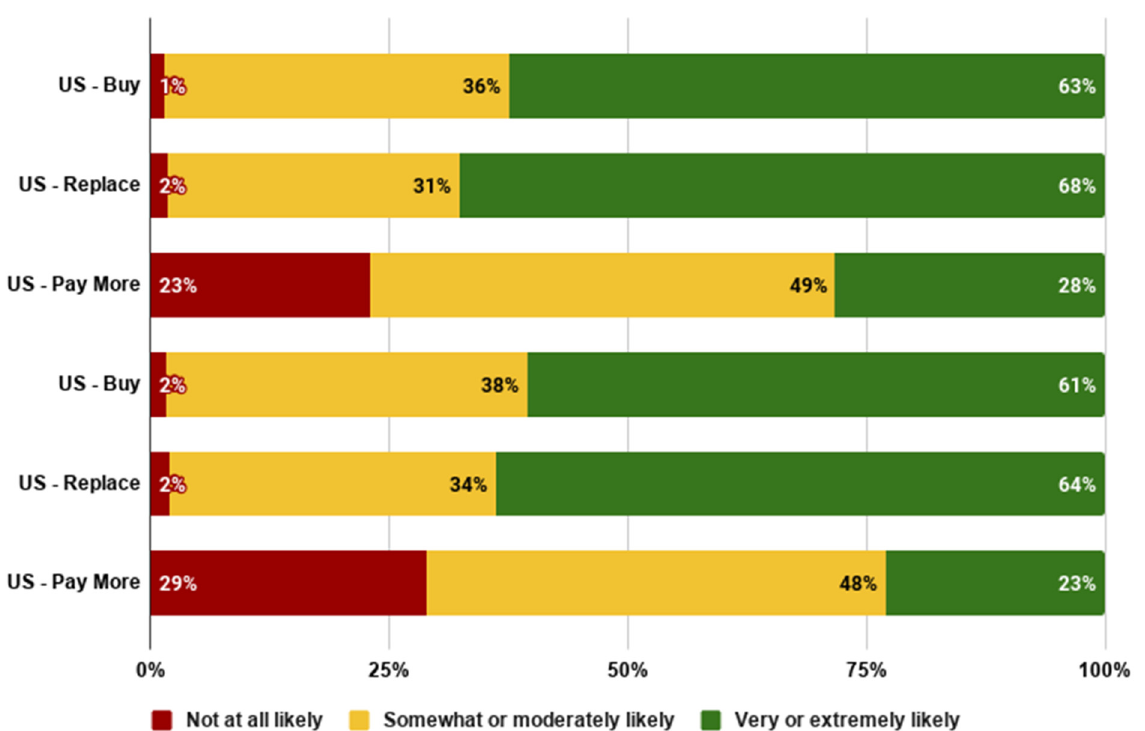
Figure 10. Likelihood of further adoption in the US and UK early majority groups. Further, we looked at the early majority’s predicted meat consumption in an imagined future where both cultivated and conventional meat were available, as measured by percentages which indicated the proportion of cultivated and conventional meat that they expected to consume. The results are shown in Figure 11 below. Results indicate that consumers in both countries expected on average 37–42% of their meat to be coming from cultivated meat. Consumers in the UK expected a slightly higher proportion to be coming from cultivated meat compared to consumers in the US. Generally, consumers envisioned cultivated meat as a partial, rather than full, replacement for conventional